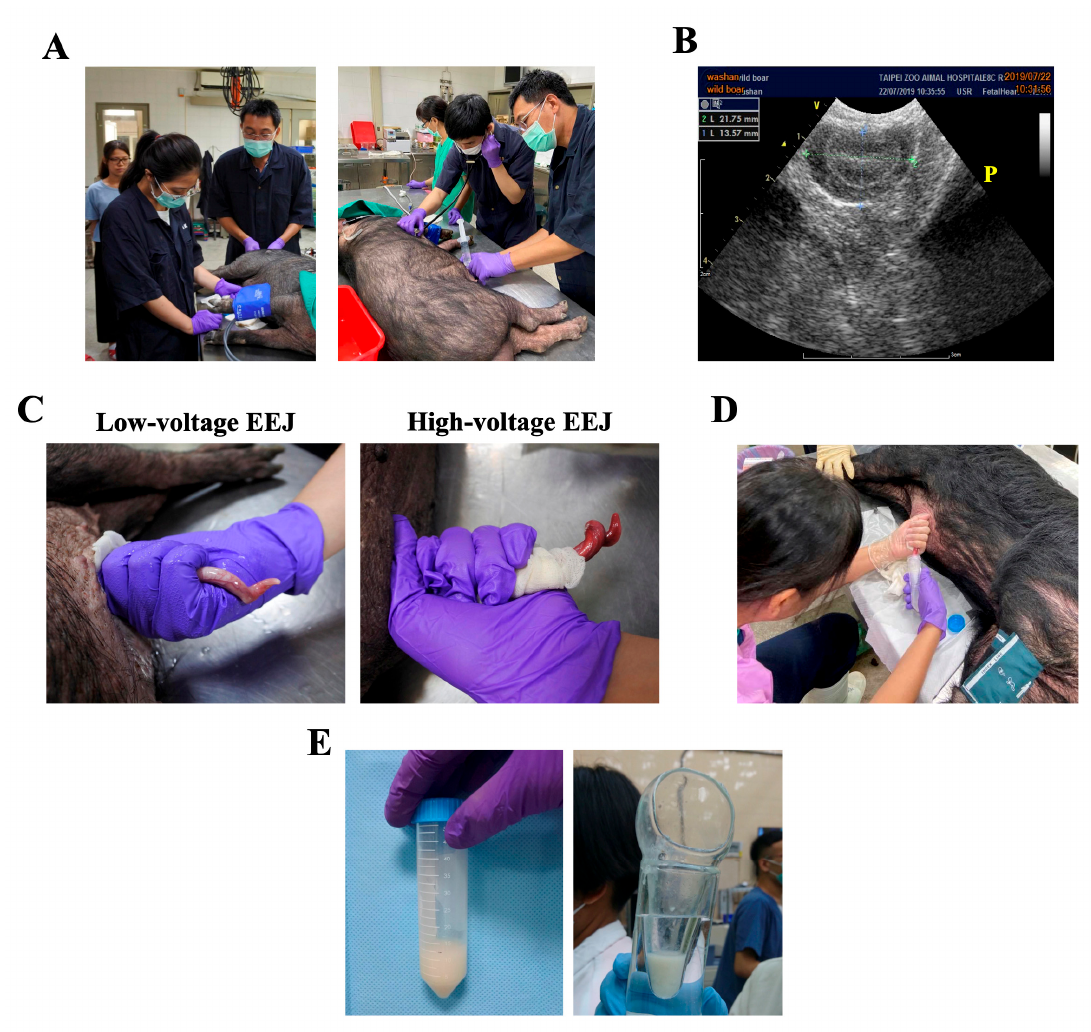
Figure 1. Electro-ejaculation procedures. ( A ) Anesthesia, physical parameters monitoring and preputial cavity disinfection of lanyu miniature pigs prior to electro-stimulation. ( B ) To ensure efficient stimulation, ultrasonography was used to localize electric probe at the prostate (indicated as “P”). ( C ) Appearance of protruded penis under both low-voltage EEJ (left panel) and high-voltage-EEJ (left panel) showed reddish and hyeremia penis at higher voltage stimulation. ( D,E ) Collection of semen ejaculates with either 50 mL sterilized plastic tube or a pre-warmed glasses container.